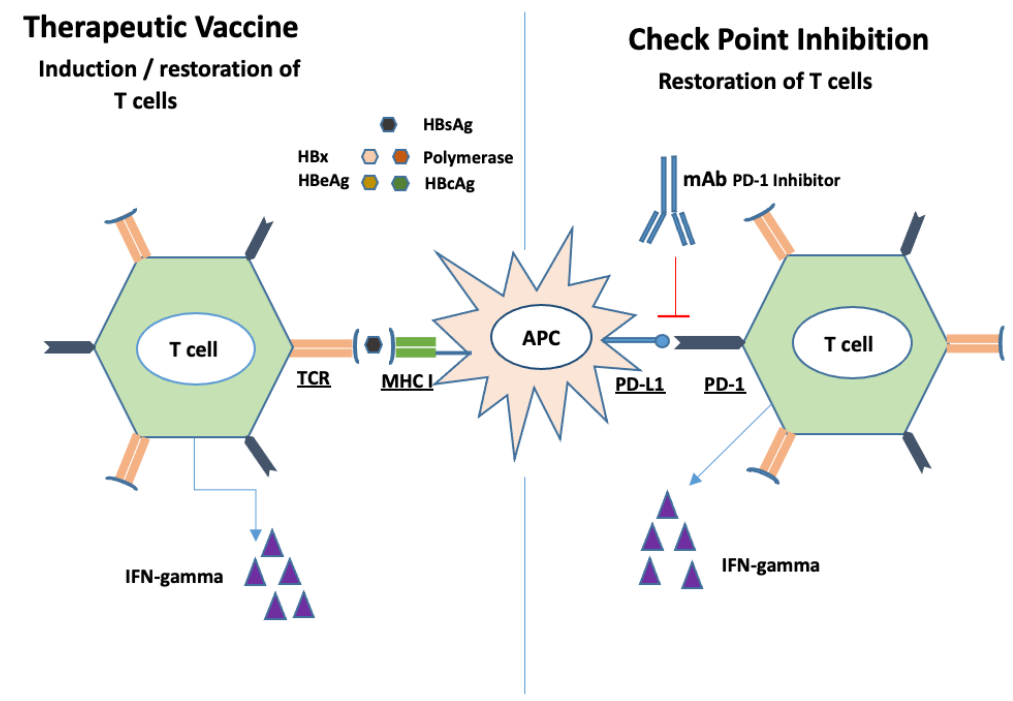
Figure 4. Restoration and induction of HBV specific T cells. Therapeutic vaccines consist of various HBV antigens which are processed by APCs. These APCs present the antigens either to new T cells inducing their function or exhausted T cells restoring their function ( Left ). Check point inhibitors block the interaction of PD-1 with PD-L1 thus boosting T cells function ( Right ).